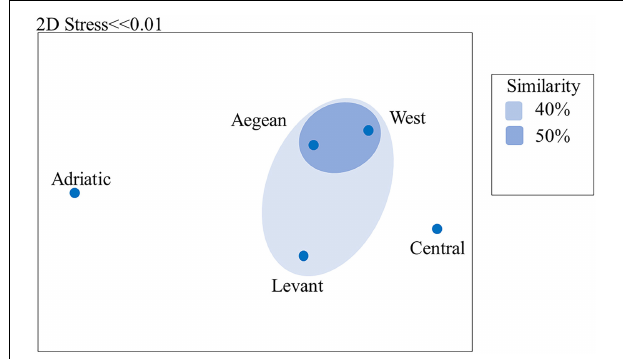
FIGURE 5 | Resemblance of sponge-associated polychaete assemblages in the Mediterranean regions demonstrated in nMDS plot. Similarity was calculated by group-average-linkage cluster-analysis.